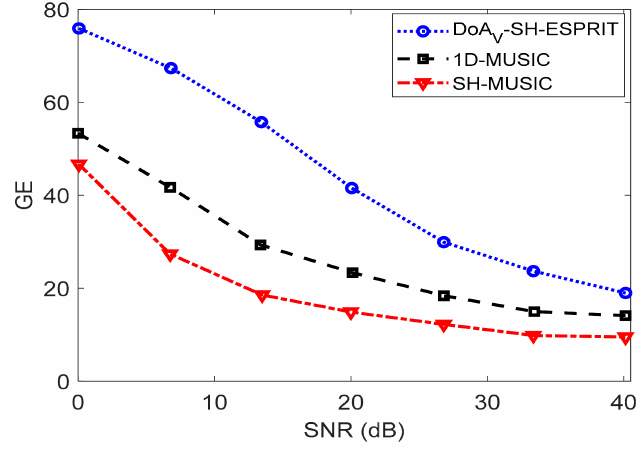
Figure 9. GE performance evaluation of methods against SNR using the measured data in